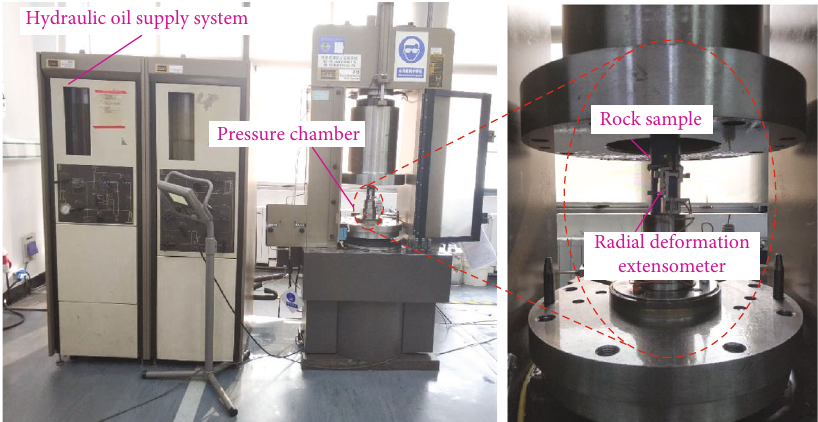
Figure 1: MTS 815.02 rock mechanics test system.